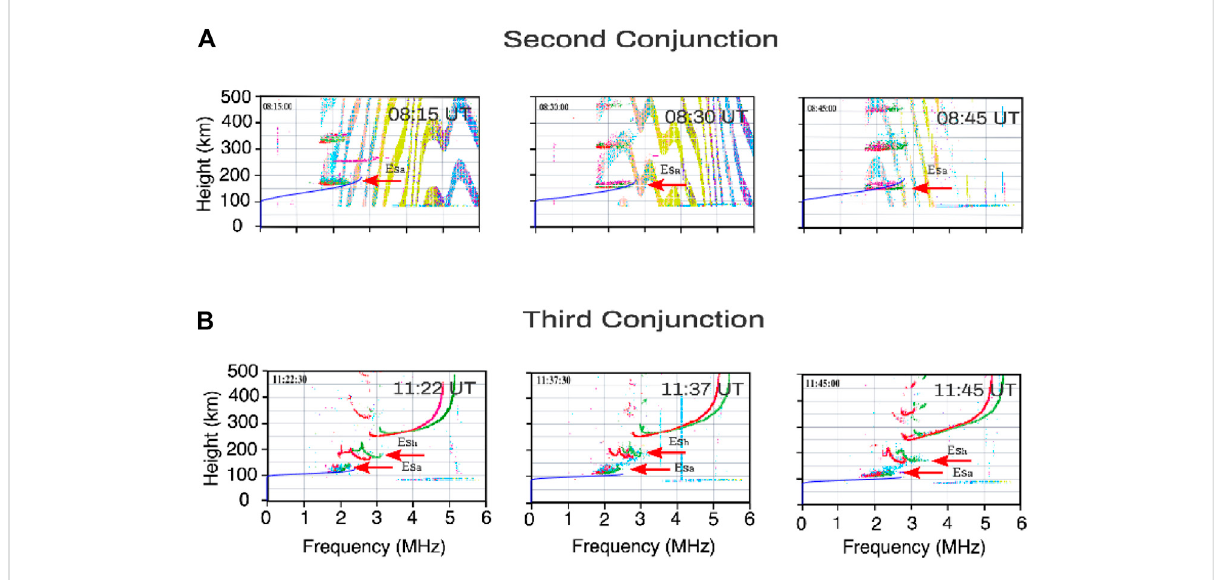
FIGURE 13 IonogramsfromDigisondelocatedatSantaMariaduringthesecond (A) ,andthird (B) conjunctions.TheredarrowsshowtheEs a layerpresence and the blue line is referent the plasma modeled frequency (MHz) altitude. Unfortunately, the Santa Maria ionograms present high 60 Hz interferences from the street lights used nearby the Digisonde